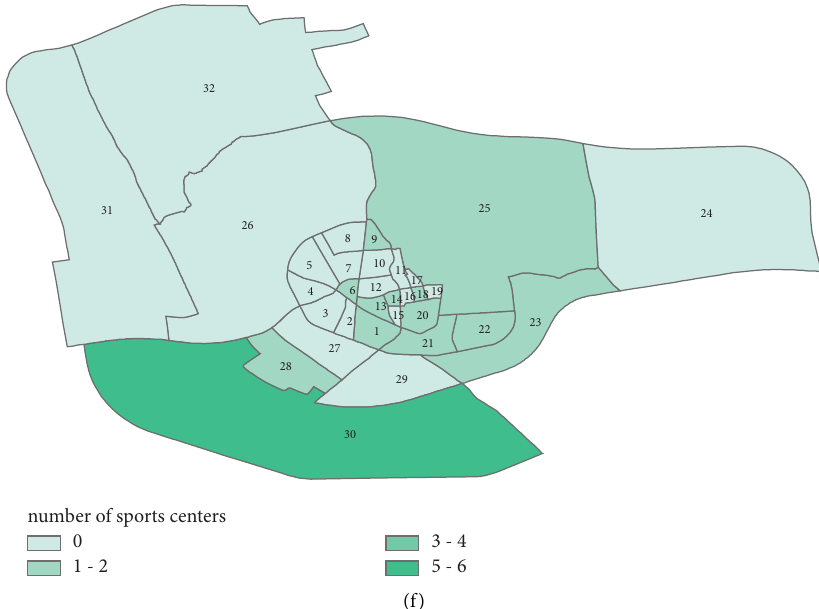
Figure 6: Spatial distributions of facilities in Xuancheng, China. (a) Ofce distributions. (b) Supermarket distributions. (c) Middle school distributions. (d) Clinic distributions. (e) Inn distributions. (f) Sports center